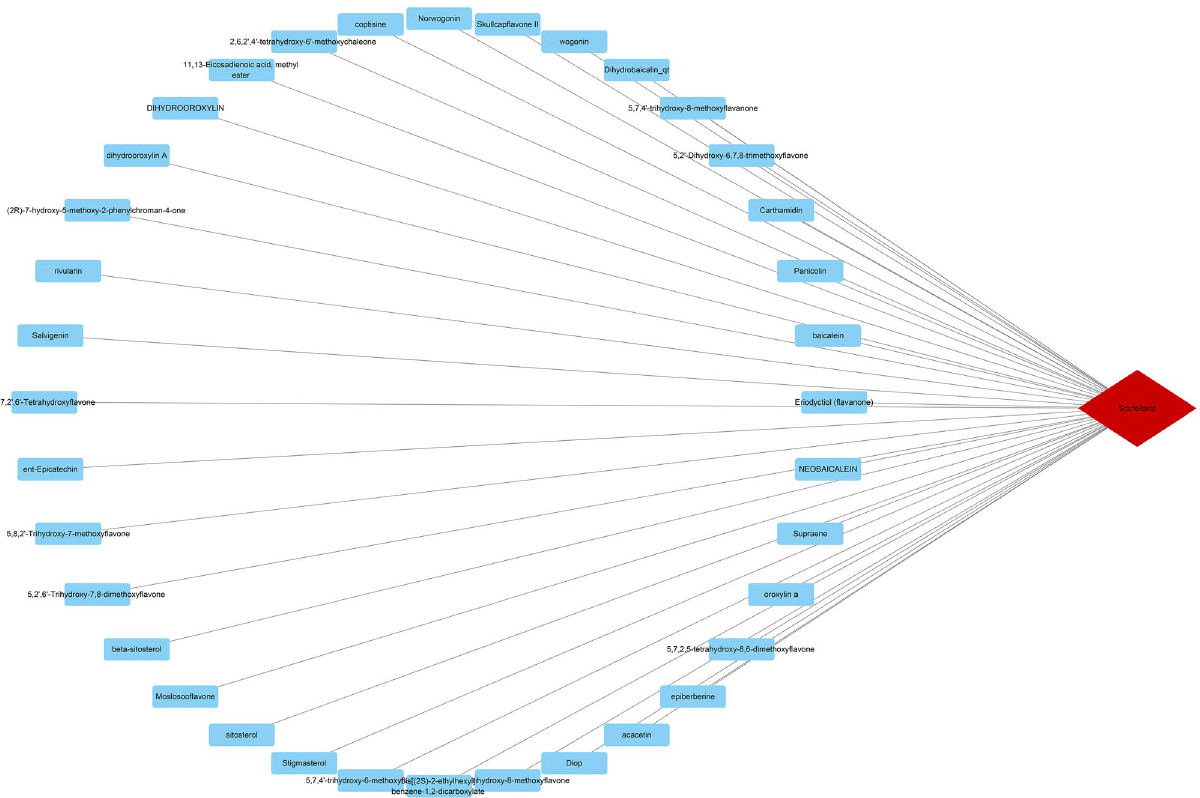
Figure 2. Drug-active ingredient network. Red diamonds represent drugs, blue rectangles represent active